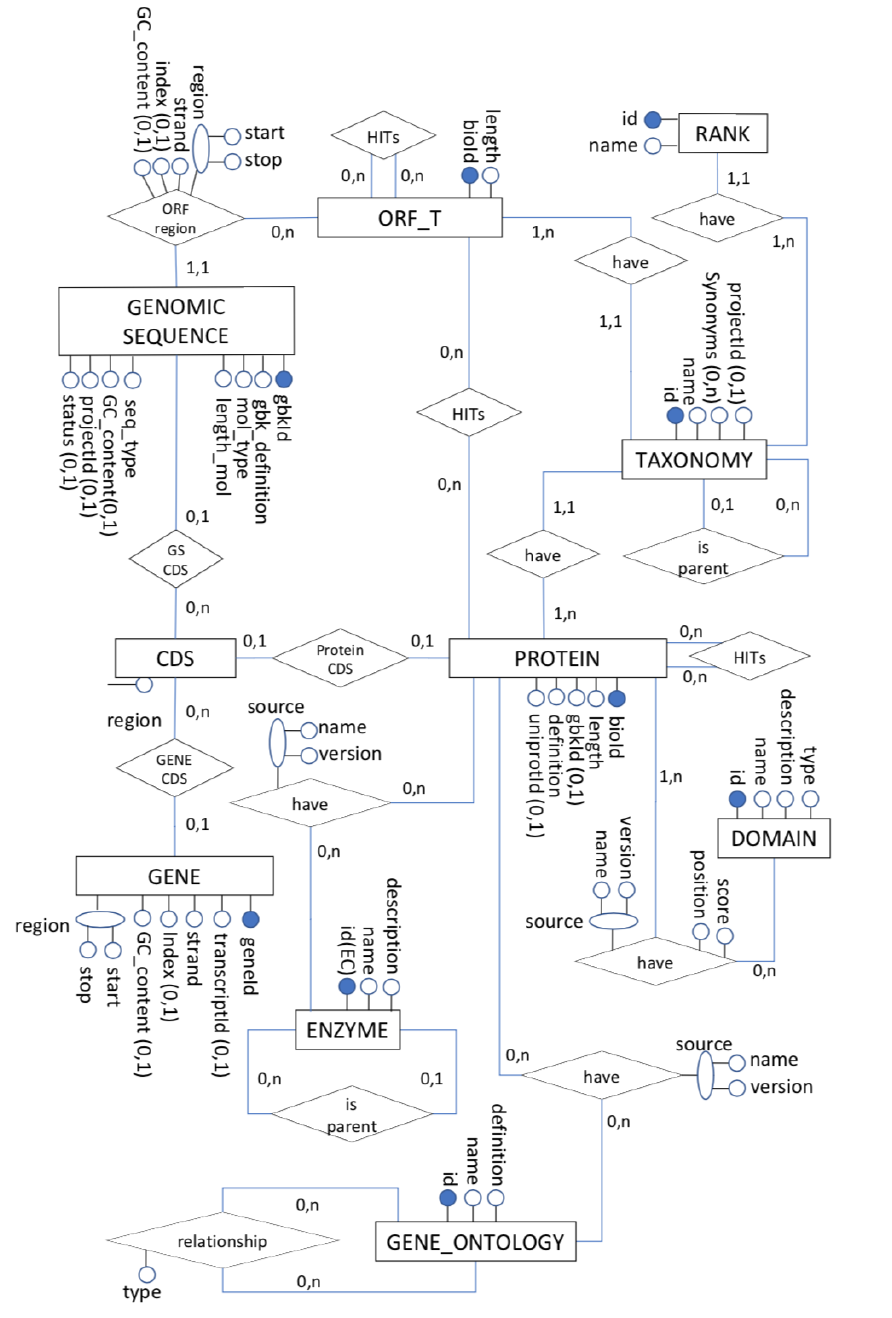
Figure 1. A Conceptual Biological Data